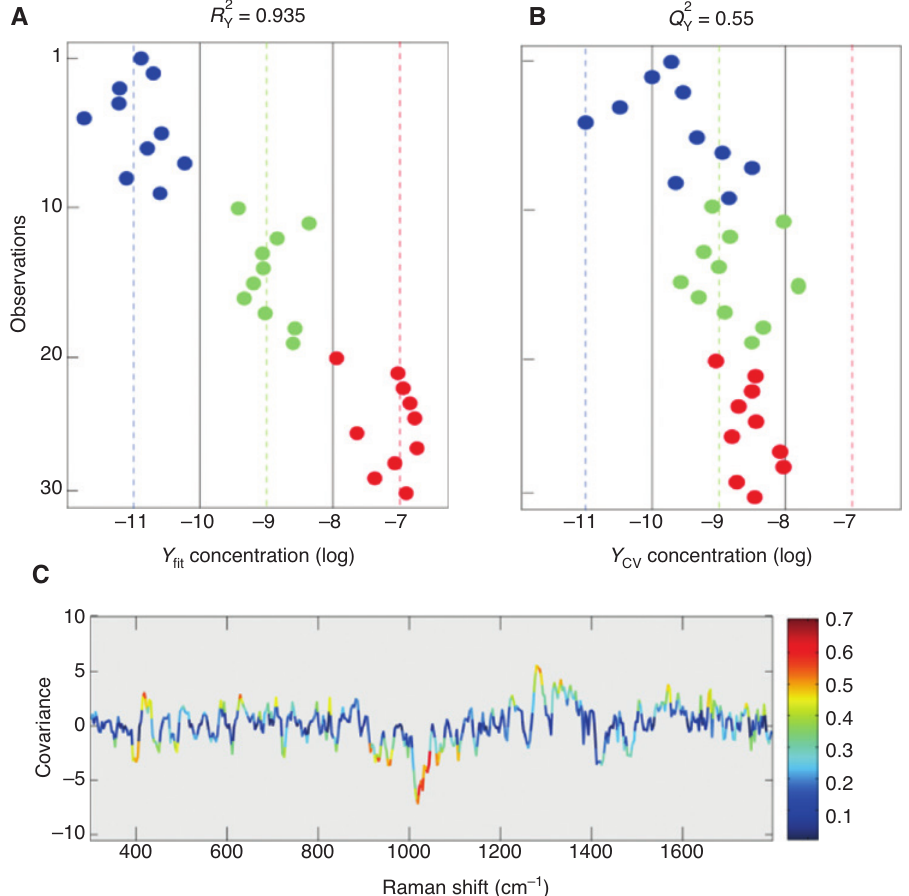
Figure 4: Prediction of MnSOD concentrations from SERS spectral variations. (A) Concentration fitting and (B) cross-validation prediction of concentrations of SERS spectra acquired from the groups of (blue) 10 pm, (green) 1 nm and (red) 100 nm. (C) Covariance between spectral intensities and MnSOD concentrations: −11 for 10 pm, −9 for 1 nm or −7 for 100 nm was added in the first row of each SERS spectrum depending on added MnSOD concentrations, and the covariance between the first row and spectral intensities at each wave number is shown in the figure. The color scale indicates correlation